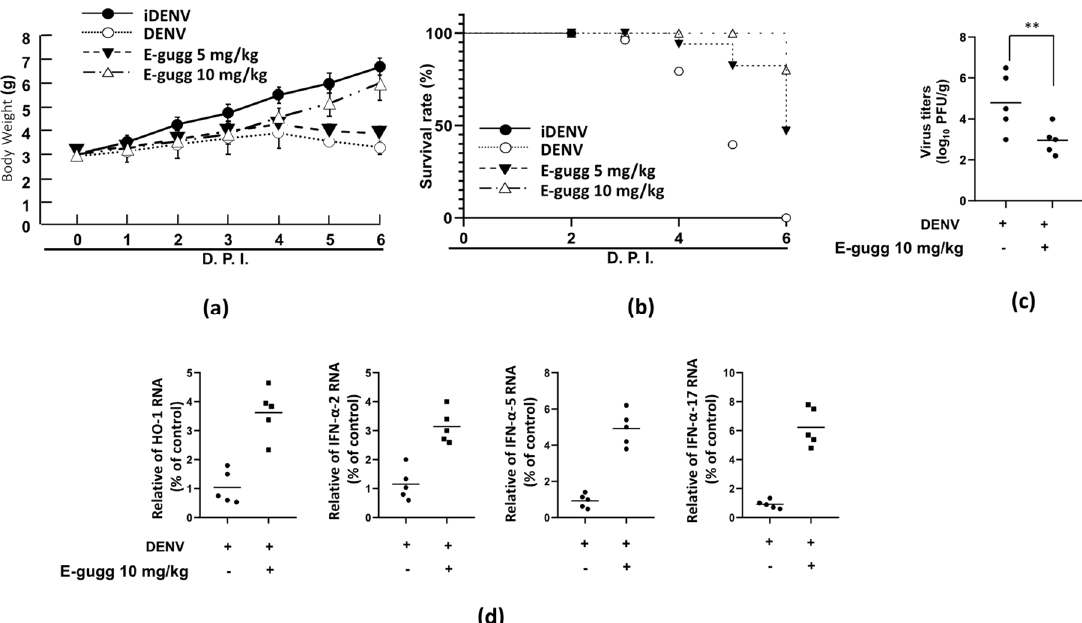
Figure 7. (E)-Guggulsterone delays DENV-2-induced lethality in the suckling mouse model. Six-day-old ICR suckling mice were injected intraperitoneally with 2.5 × 10 4 pfu DENV or heat-inactivated DENV (iDENV) (control group). DENV- infected mice were administrated either (E)-guggulsterone (5 and 10 mg/kg), marked as E-gugg, or saline (negative control) intraperitoneally at 1, 3, and 5 dpi. The ( a ) survival rate and ( b ) body weights of the mice were recorded daily measured up to 6 dpi. The ( c ) DENV titer and ( d ) gene expression of HO-1, IFN- α -2, ( b ) IFN- α -5, and ( c ) IFN- α -17 in the brain tissue were determined at 6 dpi using a plaque assay and RT-qPCR, respectively. Heat-inactivated DENV (iDENV) was administrated to the control group. Each group included 5–10 ten mice. ** p < 0.01.